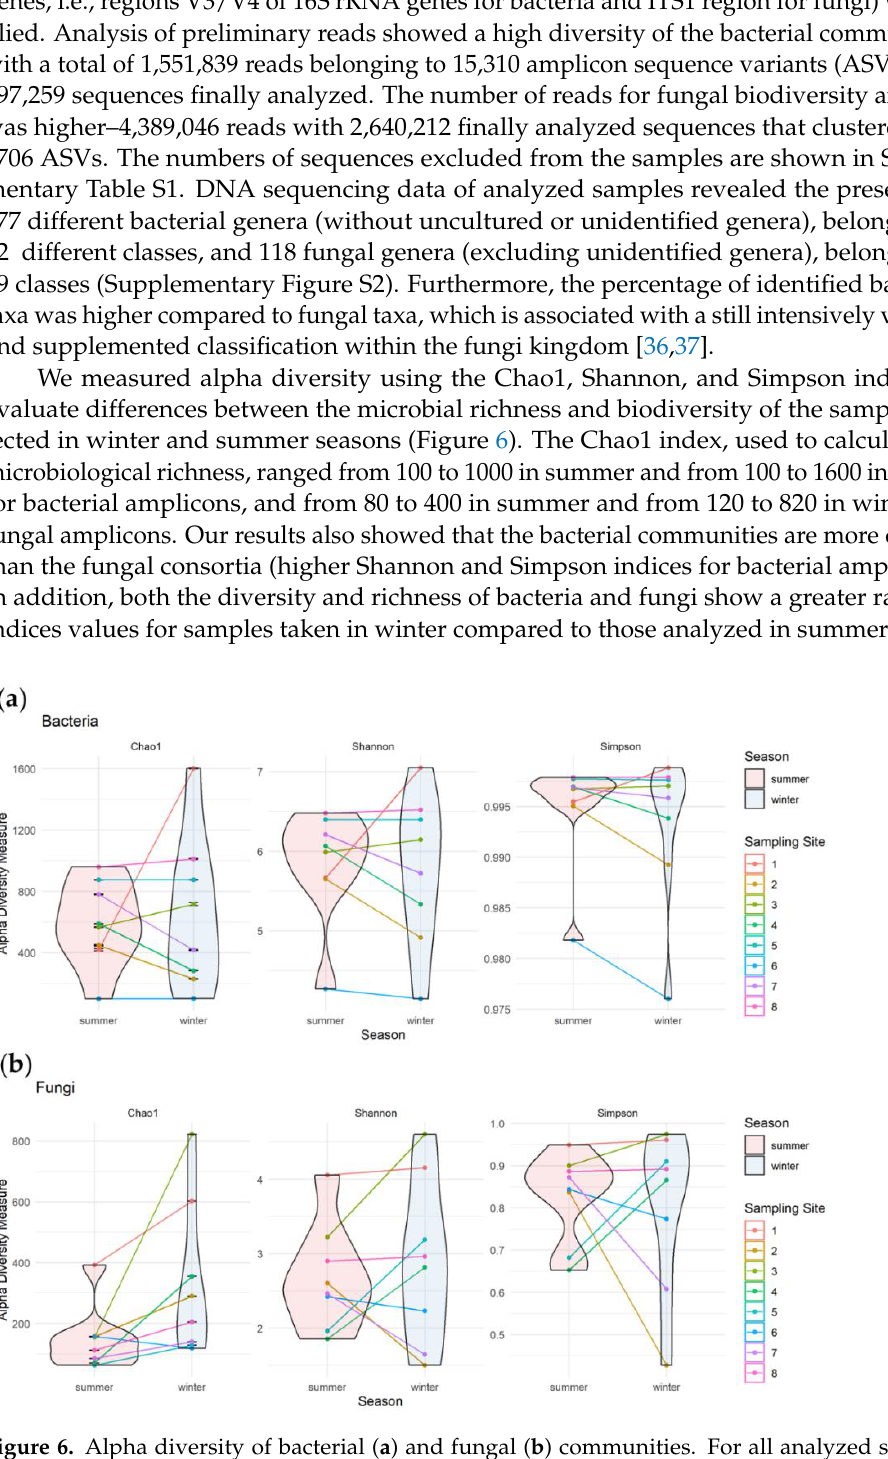
Figure 6. Alpha diversity of bacterial ( a ) and fungal ( b ) communities. For all analyzed samples, Chao1, Shannon and Simpson indices were calculated. The samples were colored and connected by sampling site, as well as grouped by season as indicated in legend.